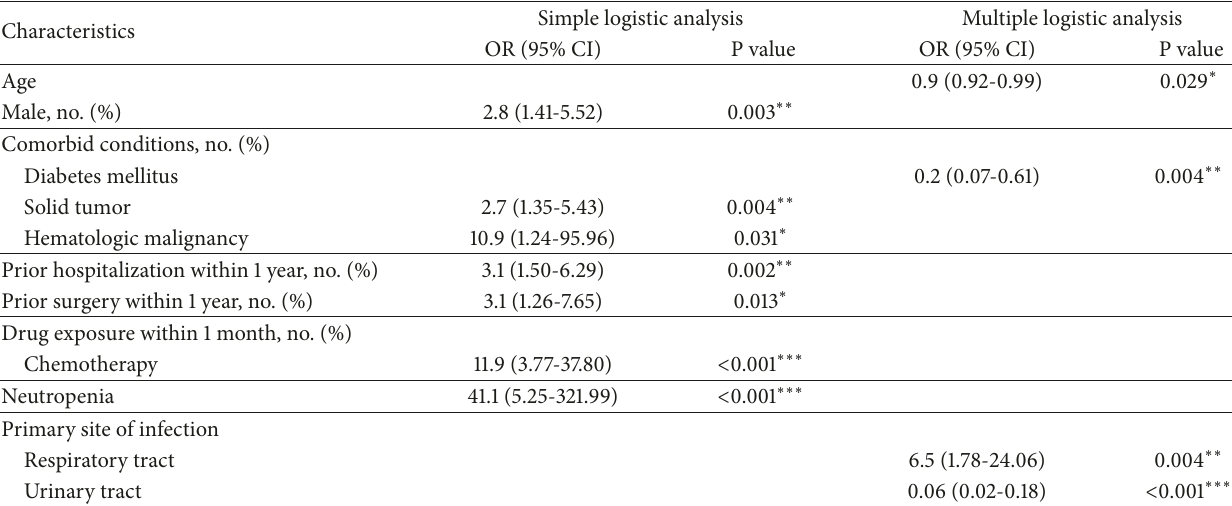
Table 3: Logistic regression analysis of clinical predictors of patients for P. aeruginosa bacteremia in the ED.